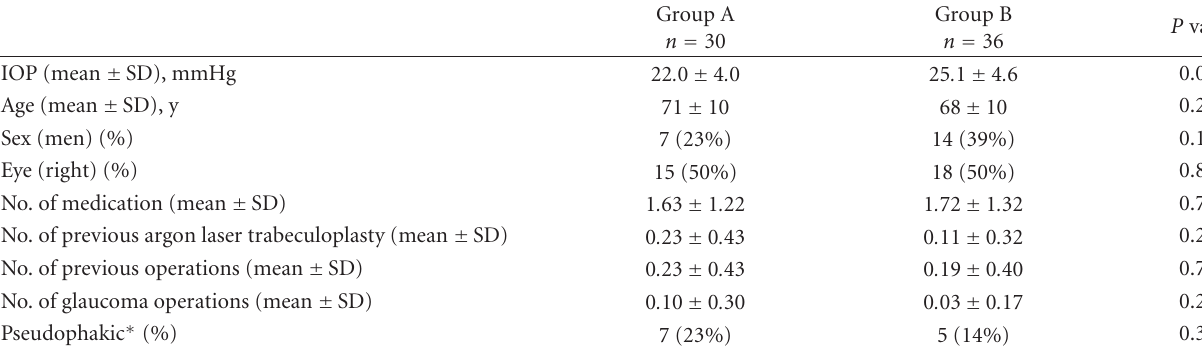
Table 1: Demographic data of the study population.